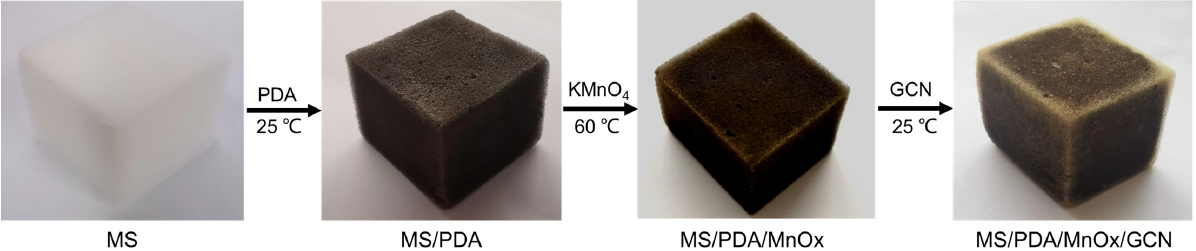
Figure 1. Schematic diagram of the sample preparation process.